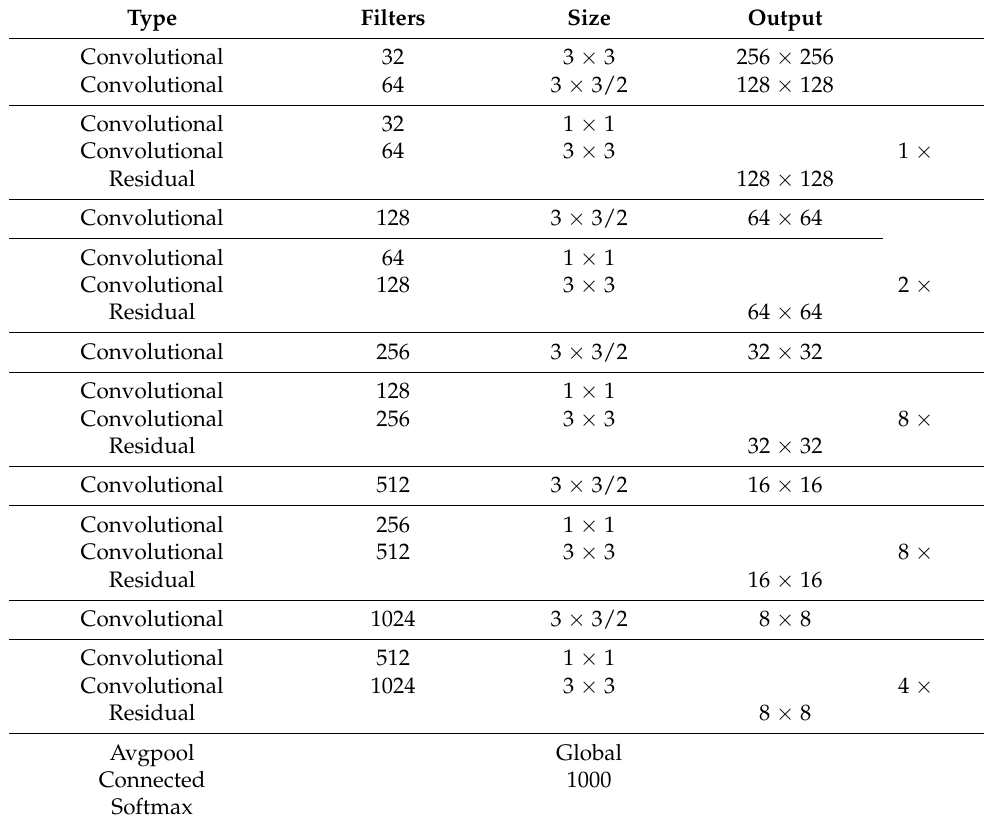
Table 1. The architecture of DarkNet-53